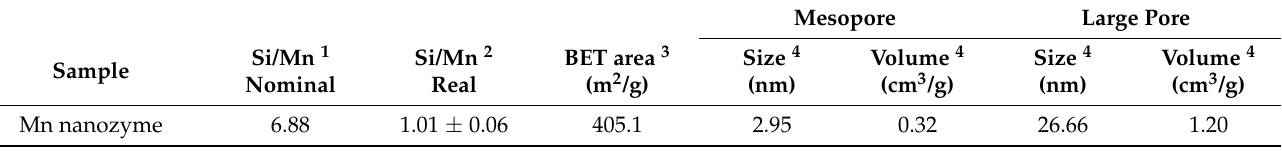
Table 1. Selected physical and textural characteristics of the MnO x -SiO 2 composite. Mesopore Large